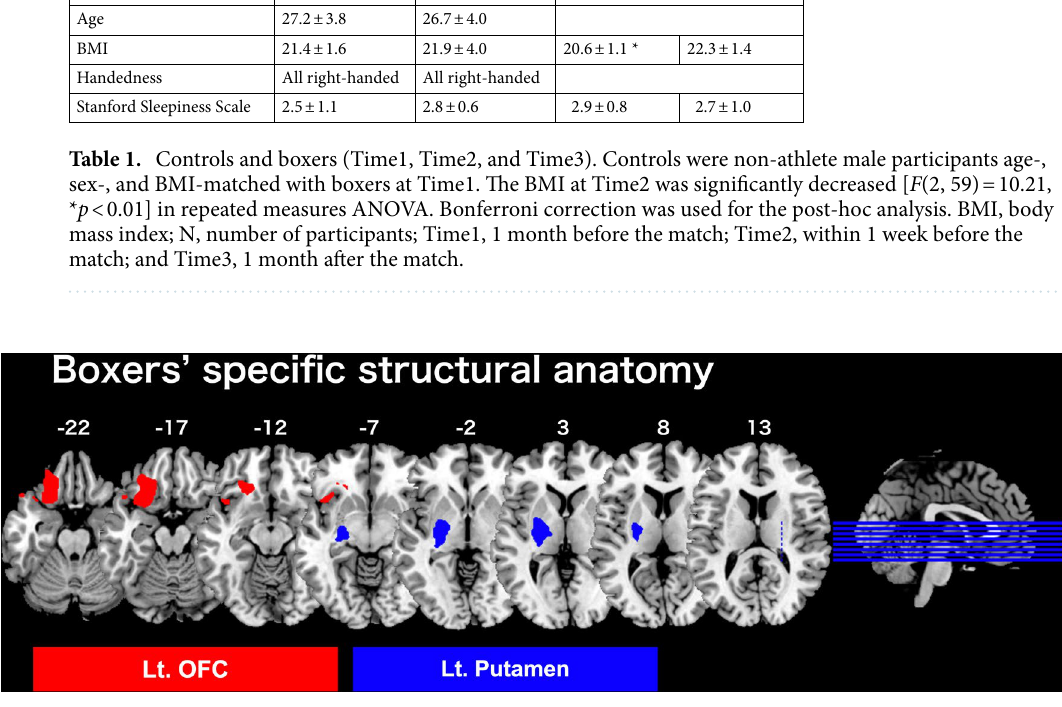
Figure 3. Boxers’ specific structural anatomy ([Boxers (Time1) > Controls]). The location of a significantly larger cluster in the left OFC and left putamen of boxers are shown as red and blue regions, respectively, on the z-axis. The statistical threshold for significant differences was set to FWE-corrected p < 0.05, at the cluster level, with uncorrected p < 0.001 at the voxel level. Lt, left; OFC, orbitofrontal